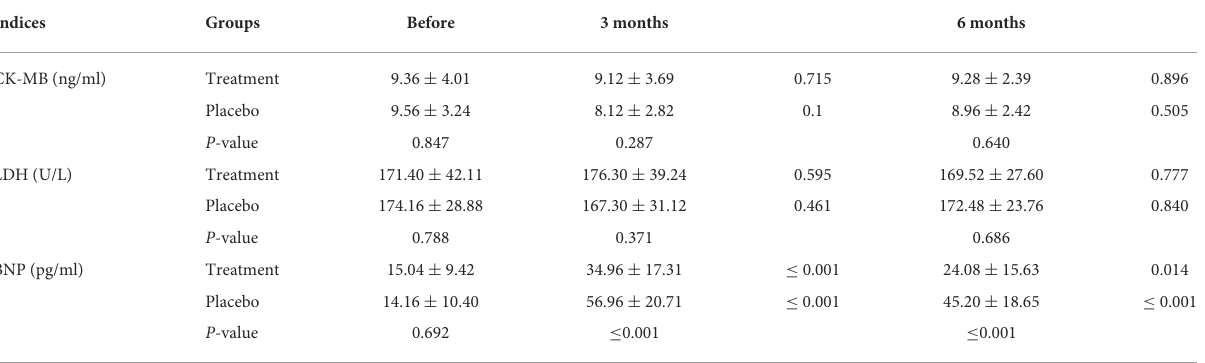
TABLE 5 Myocardial enzyme lists and related hormones (X ± SD).